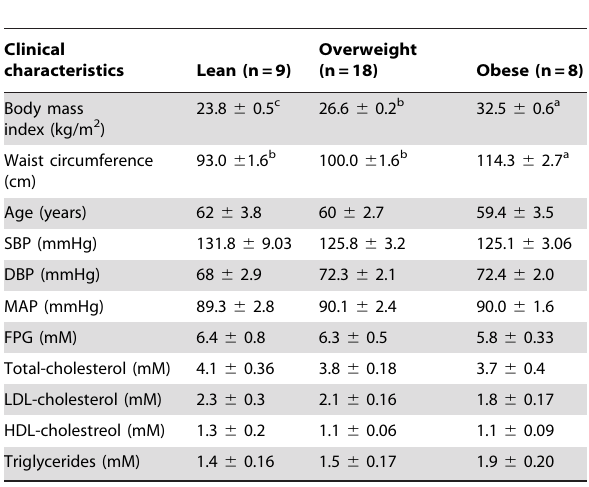
Table 1. Clinical characteristics of the subjects in the